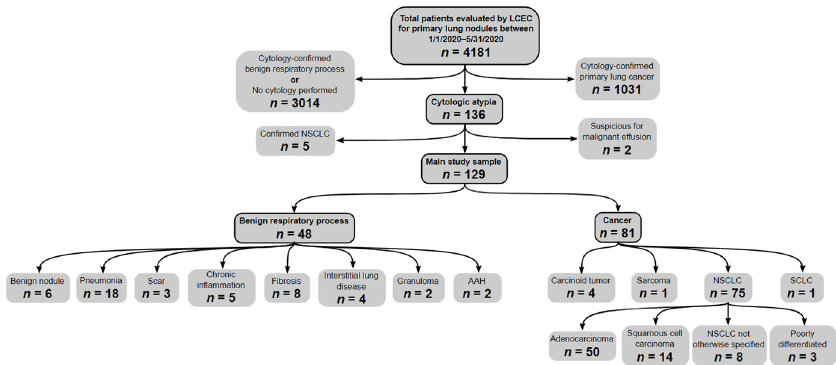
Figure 1. Study design flow chart. Note: LCEC = Lung cancer evaluation center. NSCLC = Non- small cell lung cancer. AAH = Atypical adenomatous hyperplasia. ILD = Interstitial lung disease. NOS = Not otherwise specified.